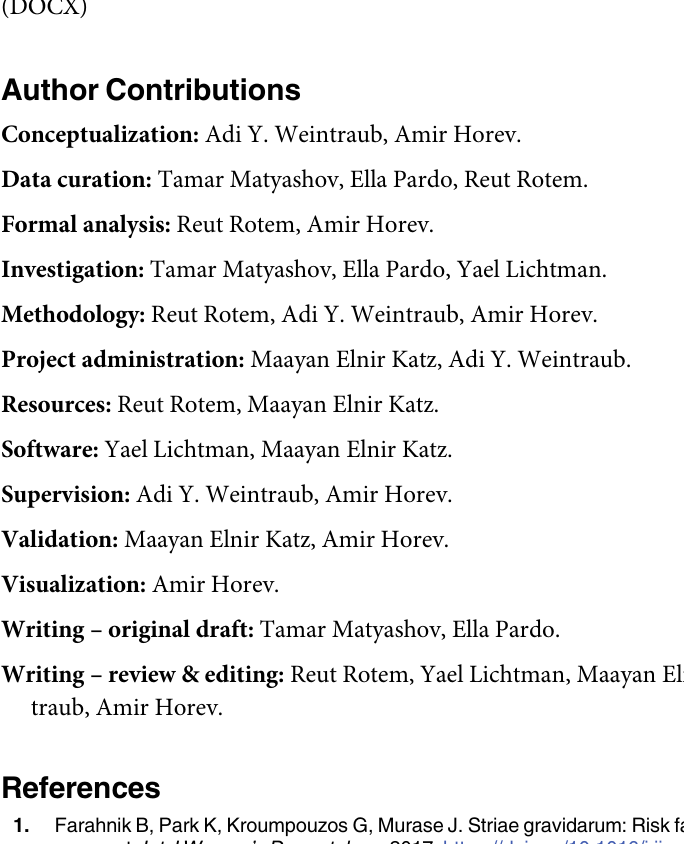
S1 Table. Demographic and clinical maternal characteristics of the study groups stratified by the presence of perineal tears. BMI—Body Mass Index; GDM—Gestational Diabetes Mel- litus; IQR–interquartile range. S2 Table. Delivery characteristics of the study groups stratified by the presence of perineal tears. � 2 cases of CS were included due to failed Vacuum extraction. CS–cesarean section; VD–vaginal